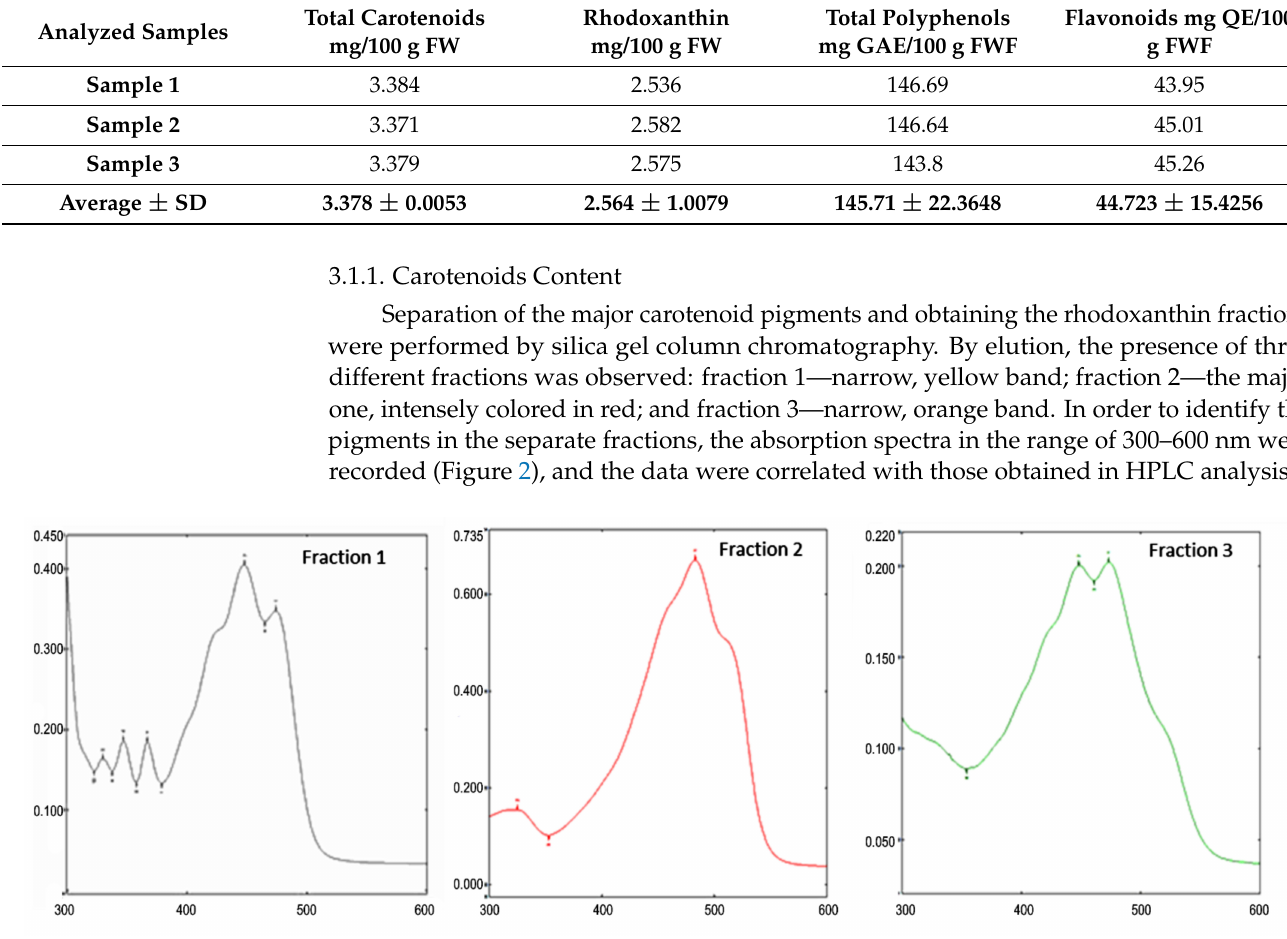
Table 1. Phytochemicals Content in Taxus baccata Aril.